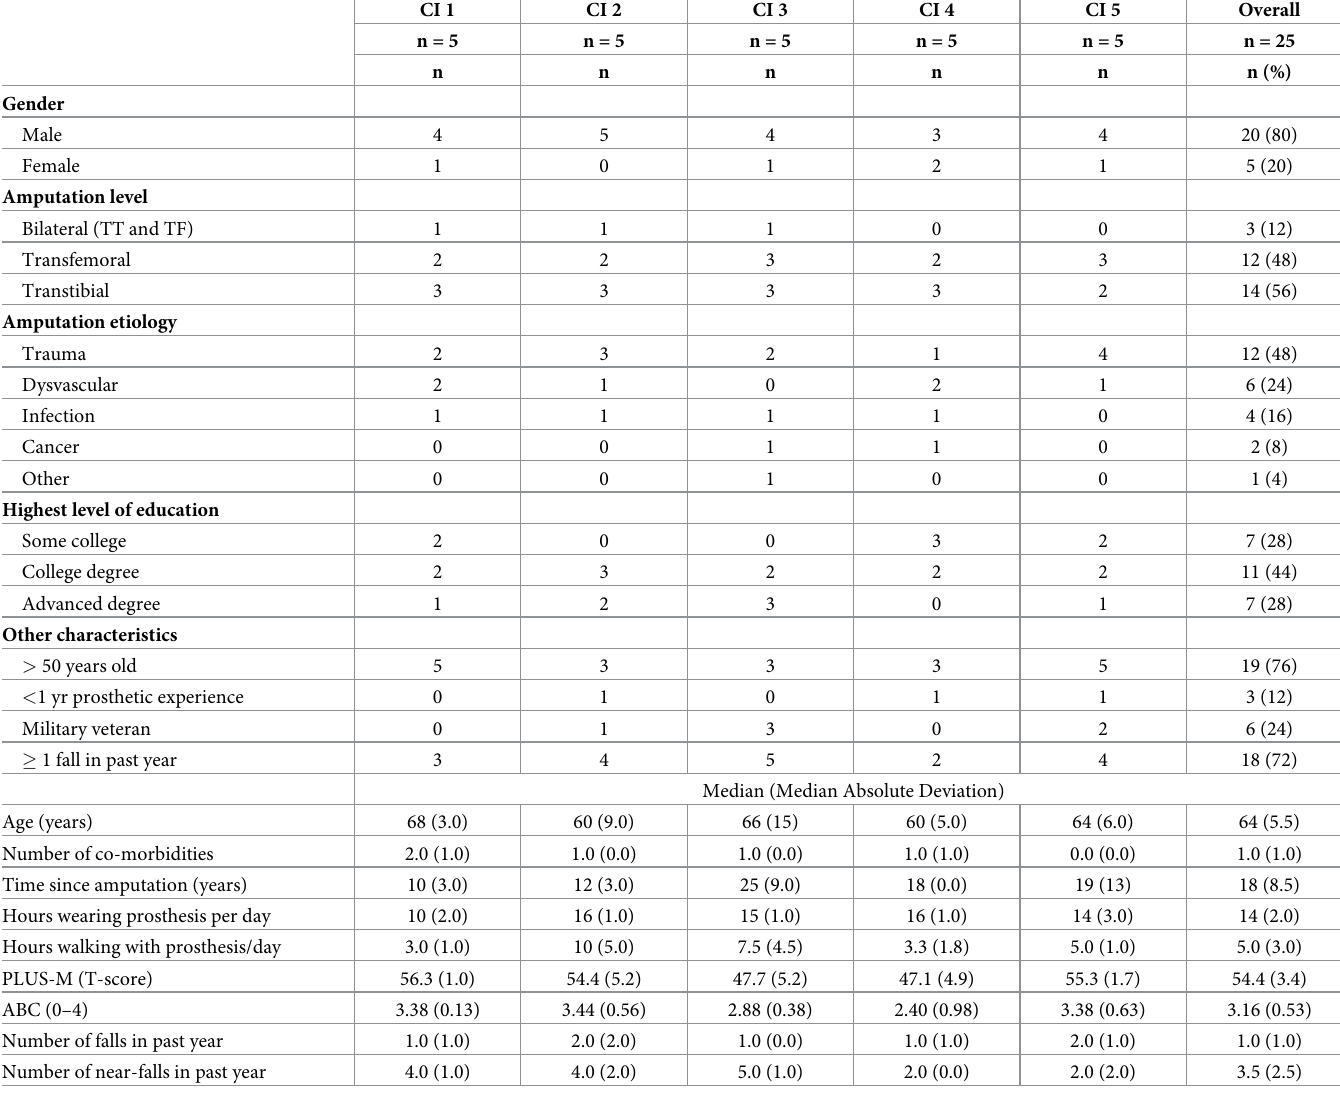
Table 2. Cognitive interview (CI) study participant characteristics (n =